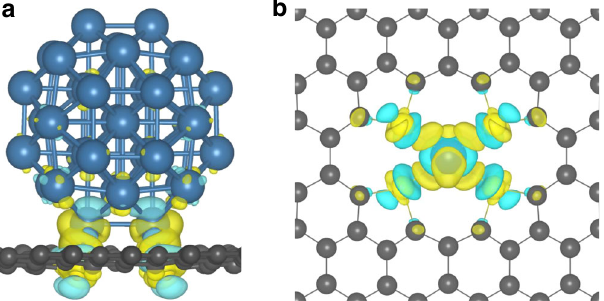
Fig. 4 Electronic structure analysis of Pt/S-Graphene. a , b Difference charge density analysis of Pt 38 /S-Graphene a and Pt 1 /S-Graphene system b . Differential charge density with yellow and cyan colors represent positive and negative electron density isosurfaces, respectively. The value of isosurface is 0.003e/bohr